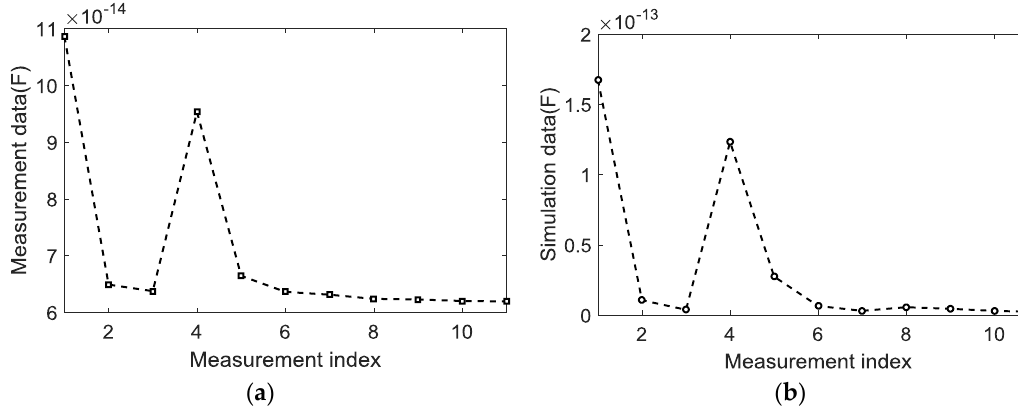
Figure 2. Capacitance data from ( a ) experiment data and ( b ) simulation data.